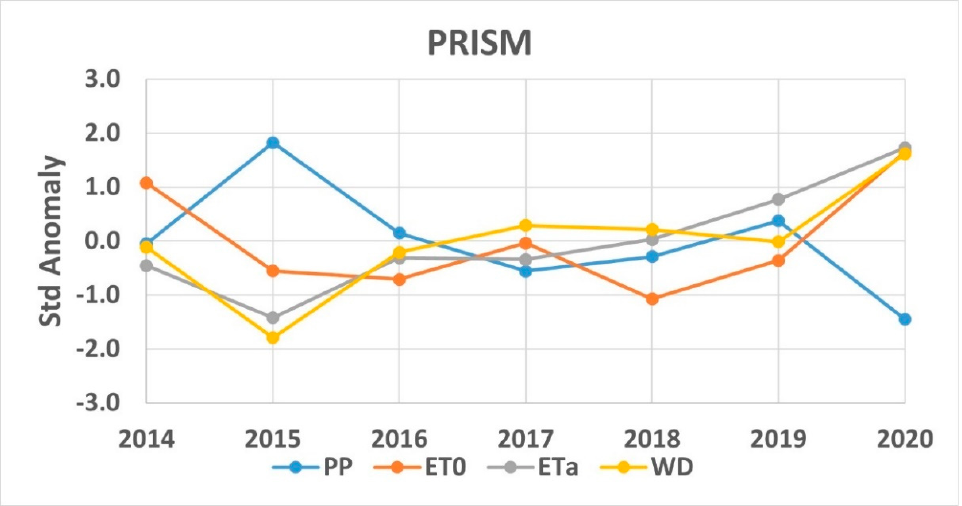
Figure 12 . Standardized anomalies as line graphs of key water metrics, precipitation (PP), potential ET (ETo), actual ET (ETa), and water deficit (WD), for seven years (2014–2020) with weather data acquired using PRISM (gridded, 4 km) but produced at 30 m resolution for the northeast corner of Arizona, which includes a large portion of the Navajo Nation.